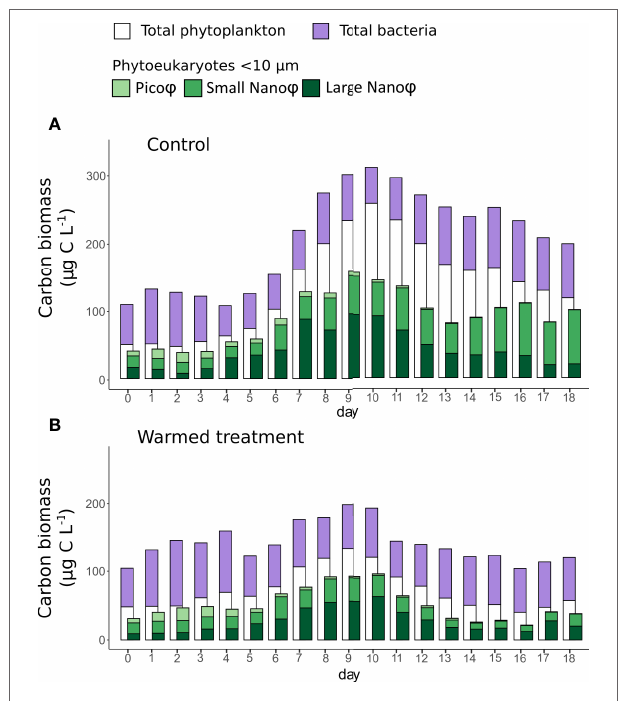
FIGURE 3 | Histograms representing the average daily carbon biomass in the control (A) and in the warmed treatment (B) of the total phytoplankton community, estimated from Chl- a measurements (white), total bacteria community estimated from cytometric count (purple) and of different phytoeukaryotes groups< 10 µm: Pico, Small Nano and Large Nano (shade of green) estimated from cytometric counts. Note that cyanobacteria biomass was extremely low all along the experiment (< 0.20 µg C L -1 ) and therefore was not plotted individually on the figure; however, cyanobacteria biomass is accounted for through total phytoplankton community